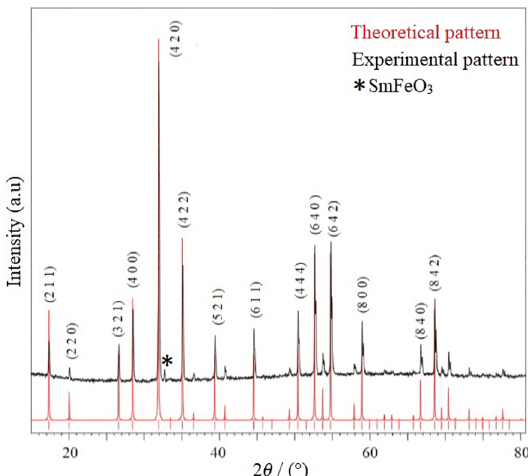
Figure 4. Diffractogram of theoretical and experimental from Sm Fe O . 3 5 12